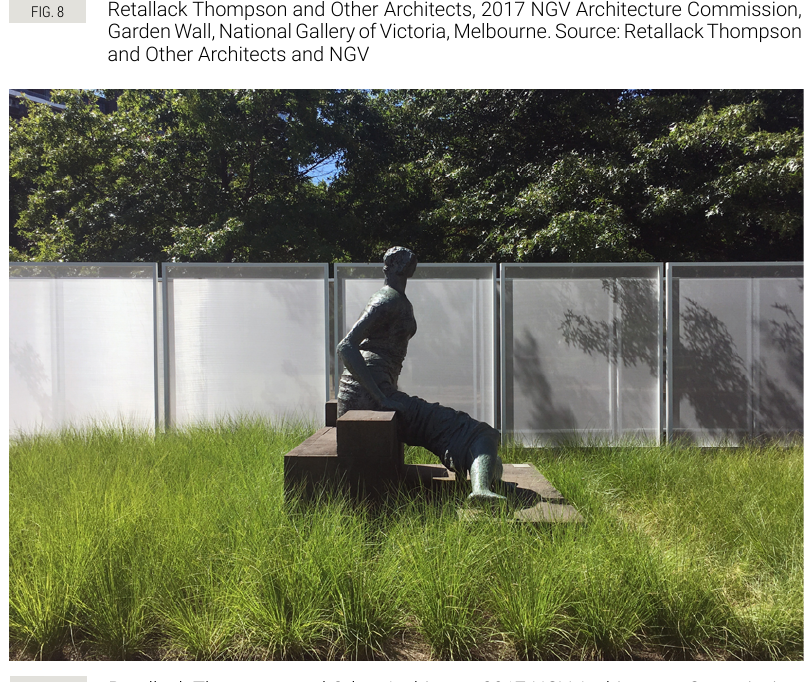
Retallack Thompson and Other Architects, 2017 NGV Architecture Commission, Garden Wall, National Gallery of Victoria, Melbourne. Source: Photograph